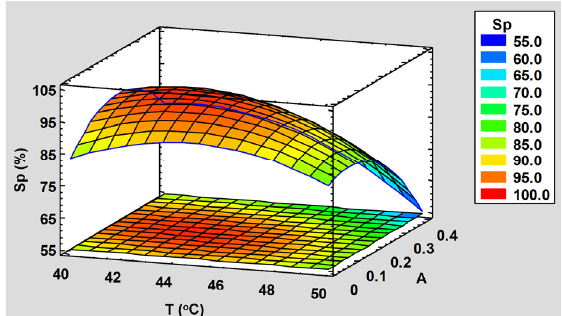
Figure 20. Effect of P and A on saponin content Sp. The saponin content Sp is affected by the first- and second-order parameters of drying temperature T, intermittency ratio A and first-order parameter of ultrasonic power P, and also simultaneously affected by both the temperature and intermittency ratio, as